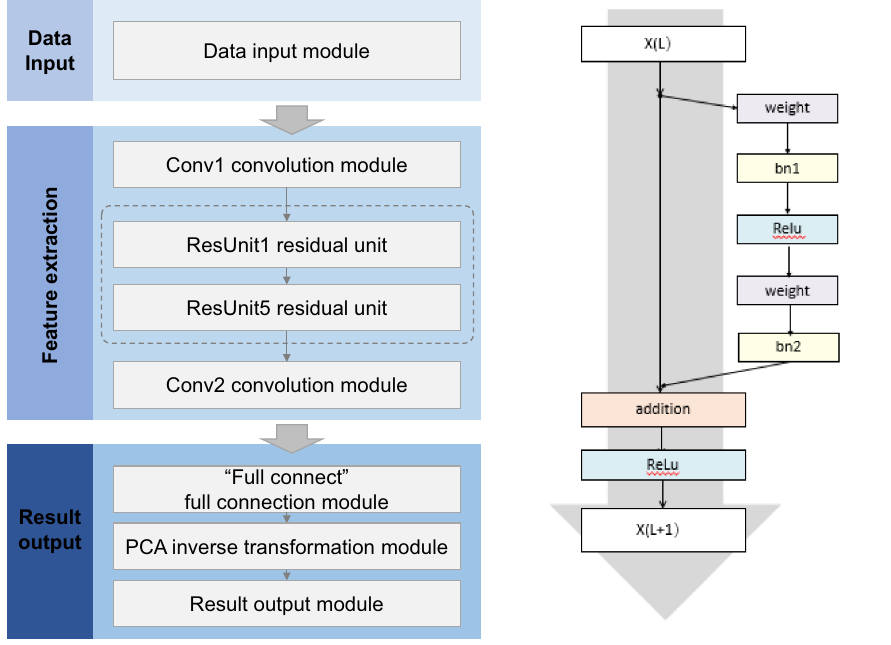
Figure 6. Schematic diagram of model construction framework and residual unit structure. Source Author